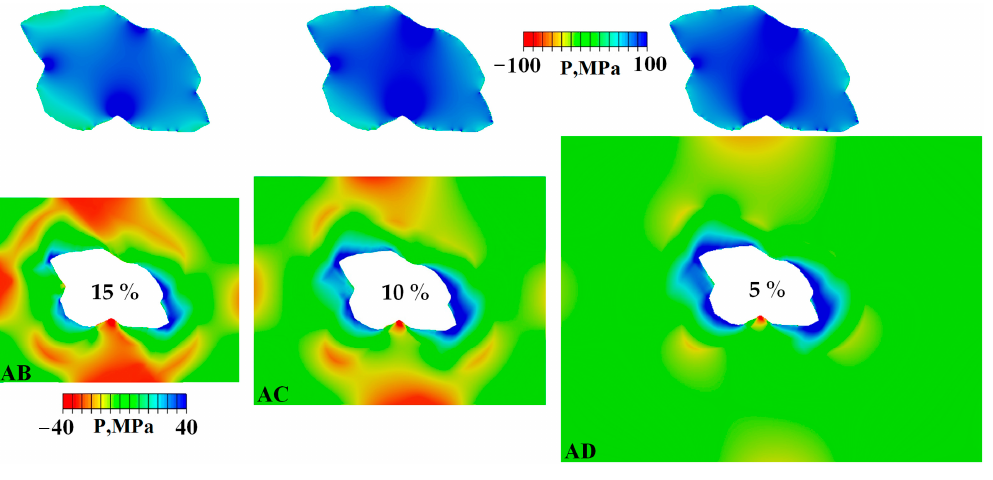
Figure 17. Pressure patterns after cooling of the Al6061T4–WC composites with varying particle volume fractions corresponding to the states AB, AC and AD shown in Figure 18.